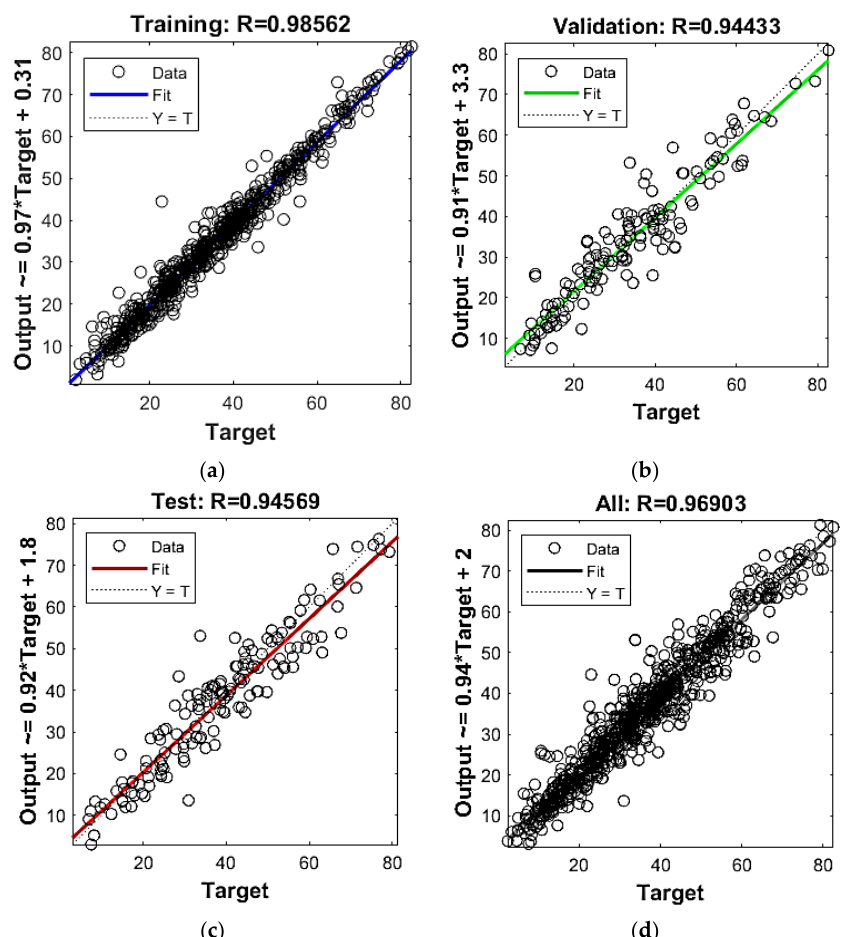
Figure 15. Two hidden layers ((50 10) number of neurons in hidden layers) neural network training regression ( a ) Training regression; ( b ) Validation regression; ( c ) Test data regression; ( d ) Combined regression of training, validation and test data.